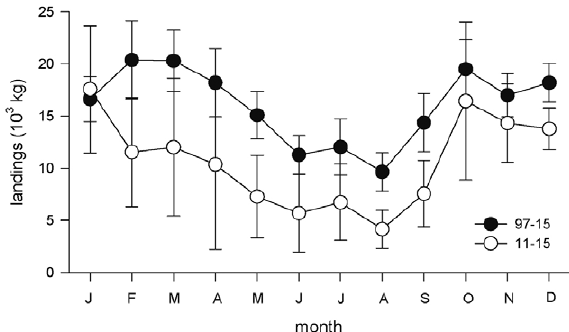
Fig. 4. – Loligo vulgaris . Monthly average and standard devia- tion of the official landings of squid (10 3 kg) in the whole Ría de Vigo (ports of Baiona, Canido, Cangas, Moaña, Panxón and Vigo) between 1997 and 2015 (black dots) and between 2011 and 2015 (white dots).